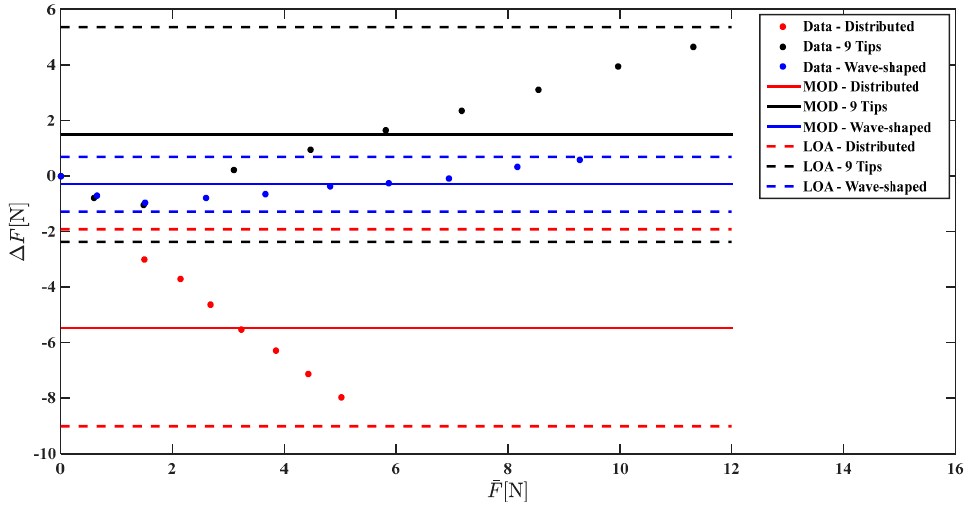
Figure 9. Bland Altman analysis comparing (cid:1832) (cid:3040) with (cid:1832) (cid:3045) for the three loading conditions (data related to Distributed load, 9 Tips load, and Wave-shaped load are shown in red, in black, and in blue, respectively).